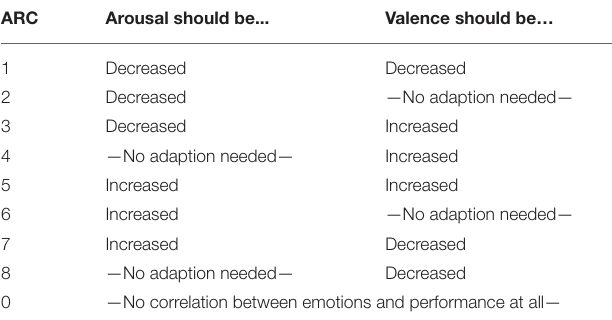
TABLE 1 | Adaption goals for arousal and valence depending on the ARC. ARC Arousal should